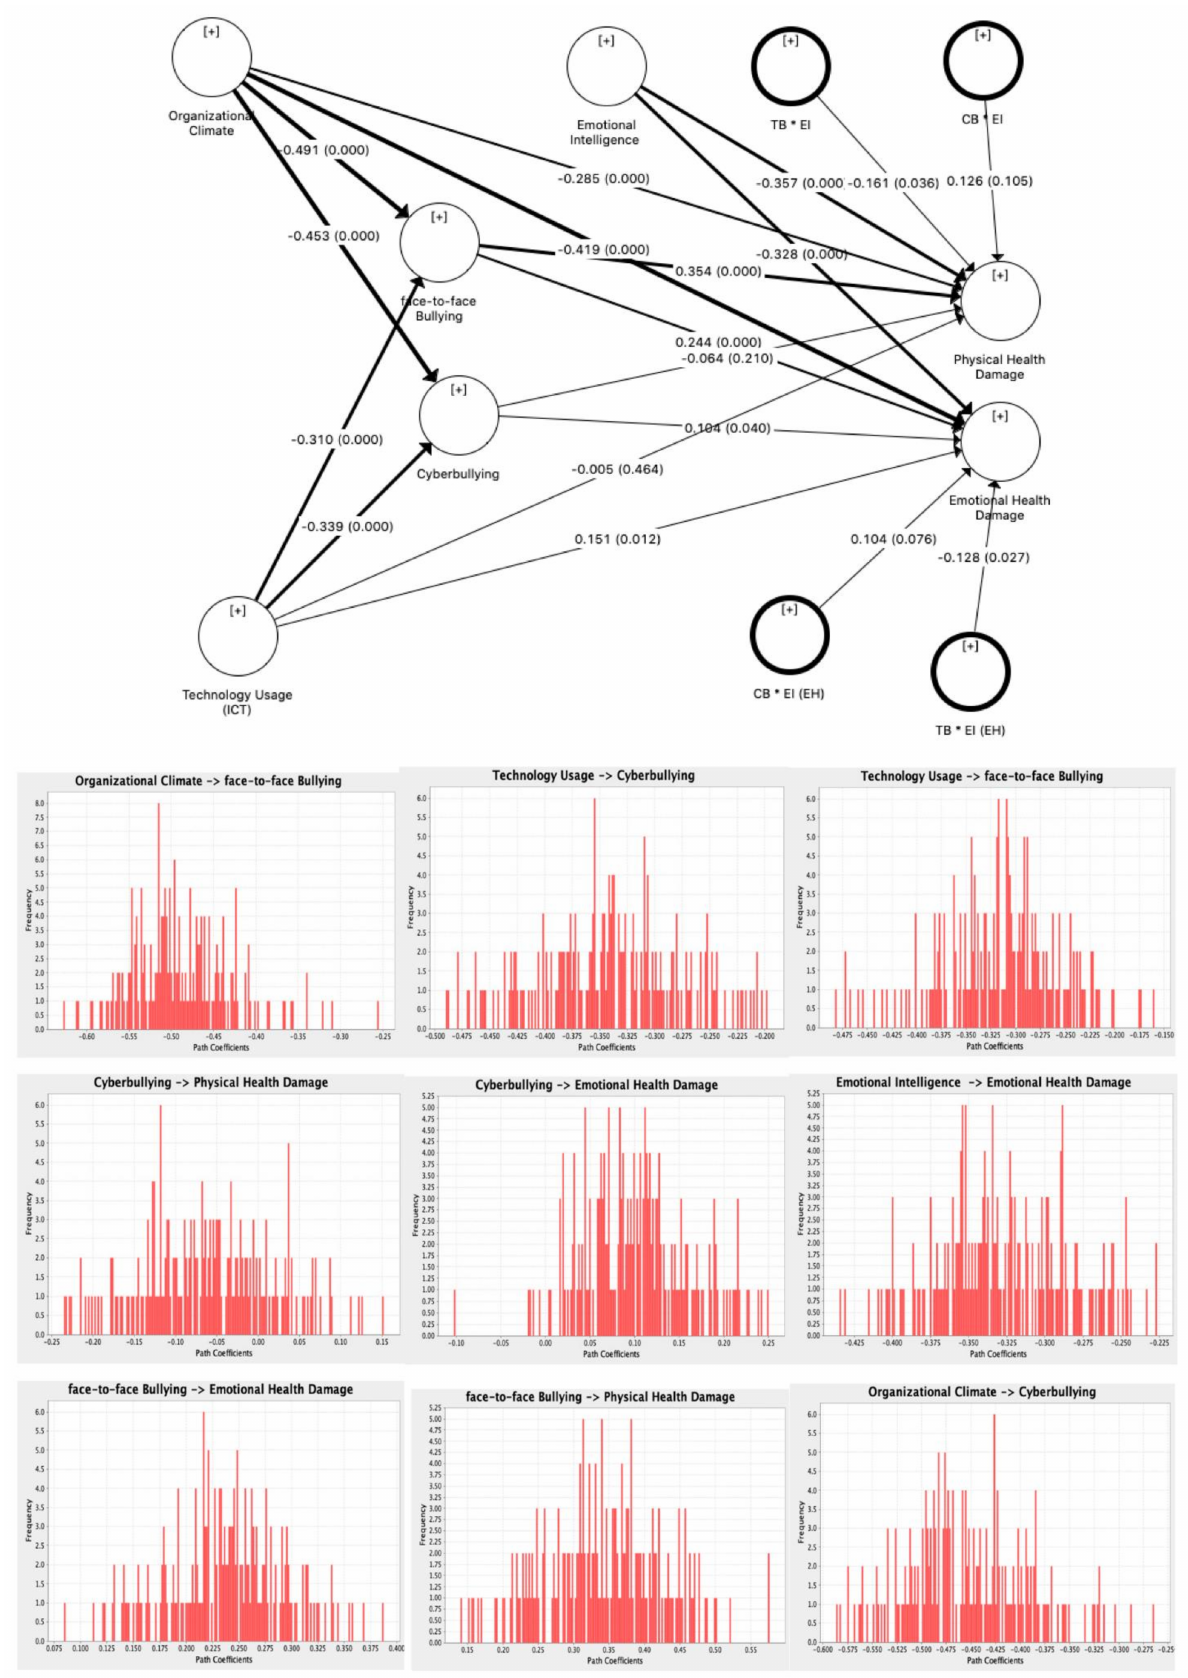
Figure 3. Structural model